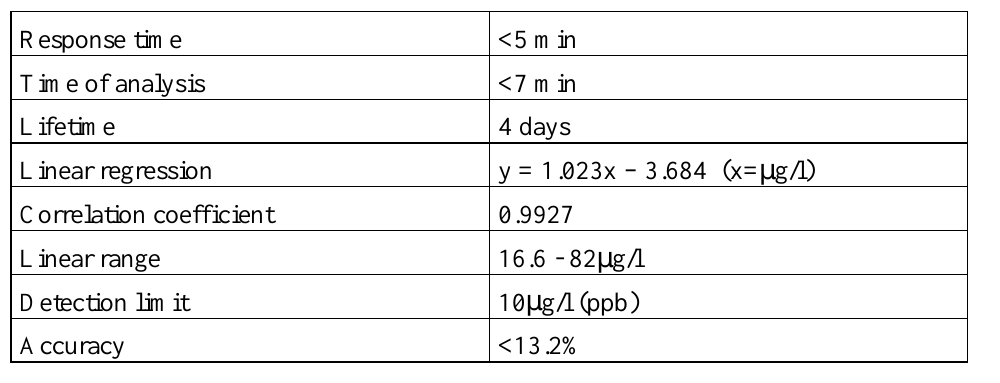
Table 2 (c). Analytical features obtained for paraoxon with an enzymatic pH-ISFET. (concentration of butyrylcholine: 5.6x10 -4 M)